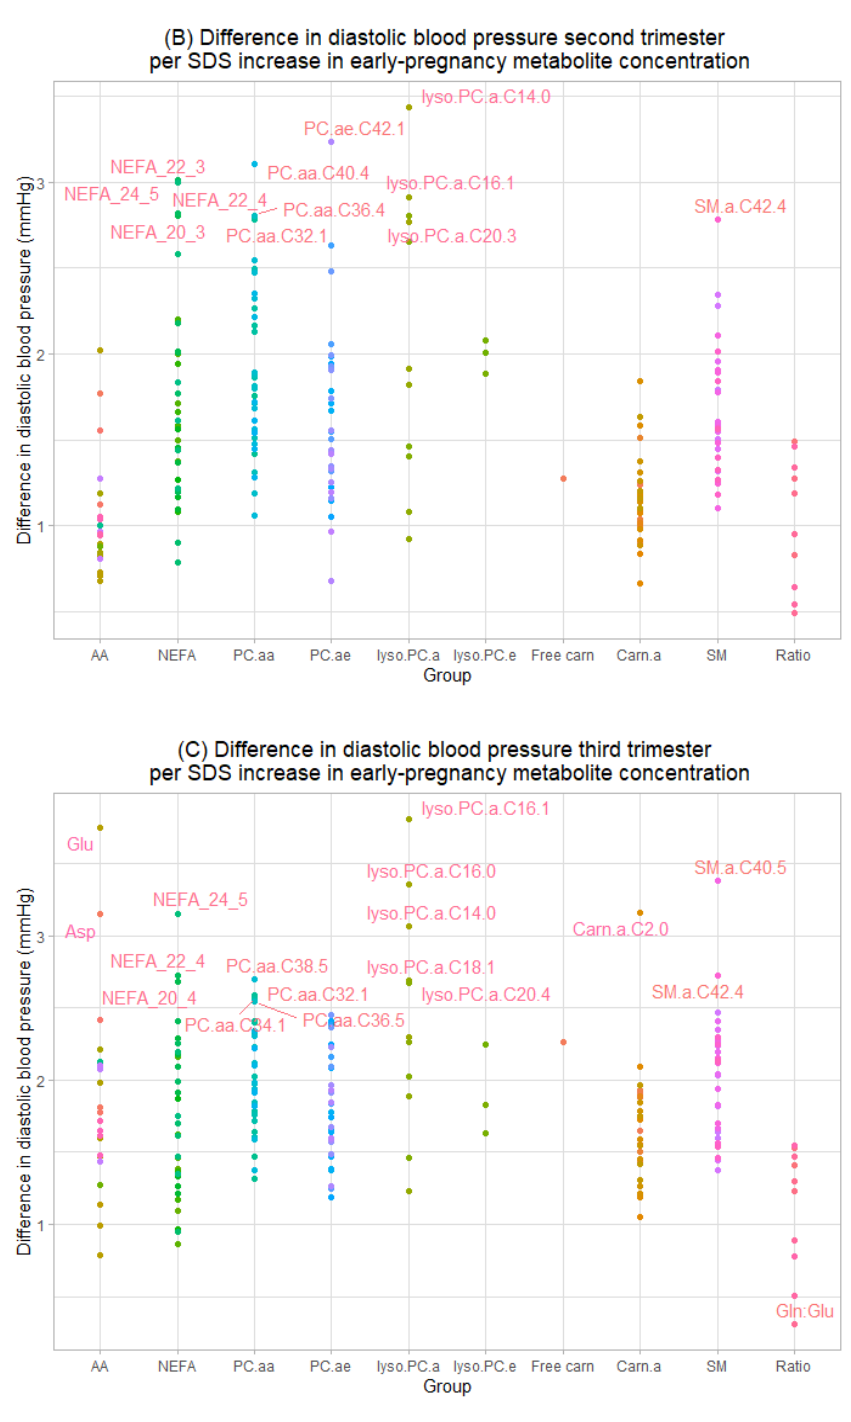
Figure 2. Associations of maternal serum early-pregnancy individual metabolites with diastolic blood pressure in ( A ) early-, ( B ) mid- and ( C ) late pregnancy. Values represent absolute differences in blood pressure from linear regression models that reflect the difference in blood pressure (mmHg) per SDS increase in maternal early-pregnancy metabolite concentrations ( µ mol/L). Model includes gestational age at time of measurement, age, parity, pre-pregnancy body mass index, educational level, smoking and folic acid supplementation. Labeled values represent significant associations (FDR-adjusted p -values < 0.05). Corresponding numerical values are shown in Table S5. AA amino acids, NEFA non-esterified fatty acids, PC.aa diacyl-phosphatidylcholines, PC.ae acyl-alkyl-phosphatidylcholines, lyso.PC.a acyl-lysophosphatidylcholines, lyso.PC.e alkyl-lysophosphatidylcholines, Carn.a acyl- carnitines, SM